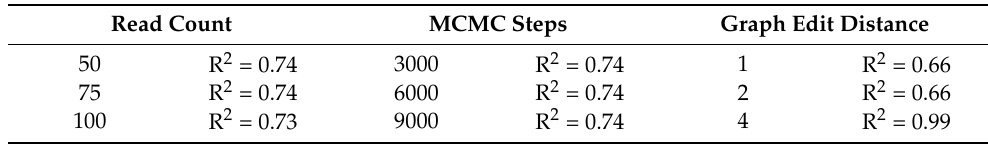
Figure 6. Scatter plots depicting estimated mixture ratios (x axis) against their predicted values (y axis) for six different ratios as they related to each tested parameter, namely read count ( A ), number of MCMC steps ( B ), and the graph edit distance ( C ). Each subplot represents a specific value for the chosen parameter, namely 50, 75, and 100 for ( A ), 3000, 6000, and 9000 for ( B ), and 1, 2, and 4 for ( C ). The color represents pairwise distances, ranging from 10–50, between haplotypes in each mixture. Table 4. Comparing coefficients of determination for different parameters as they relate to the goodness of fit of the relationship between expected and observed mixture